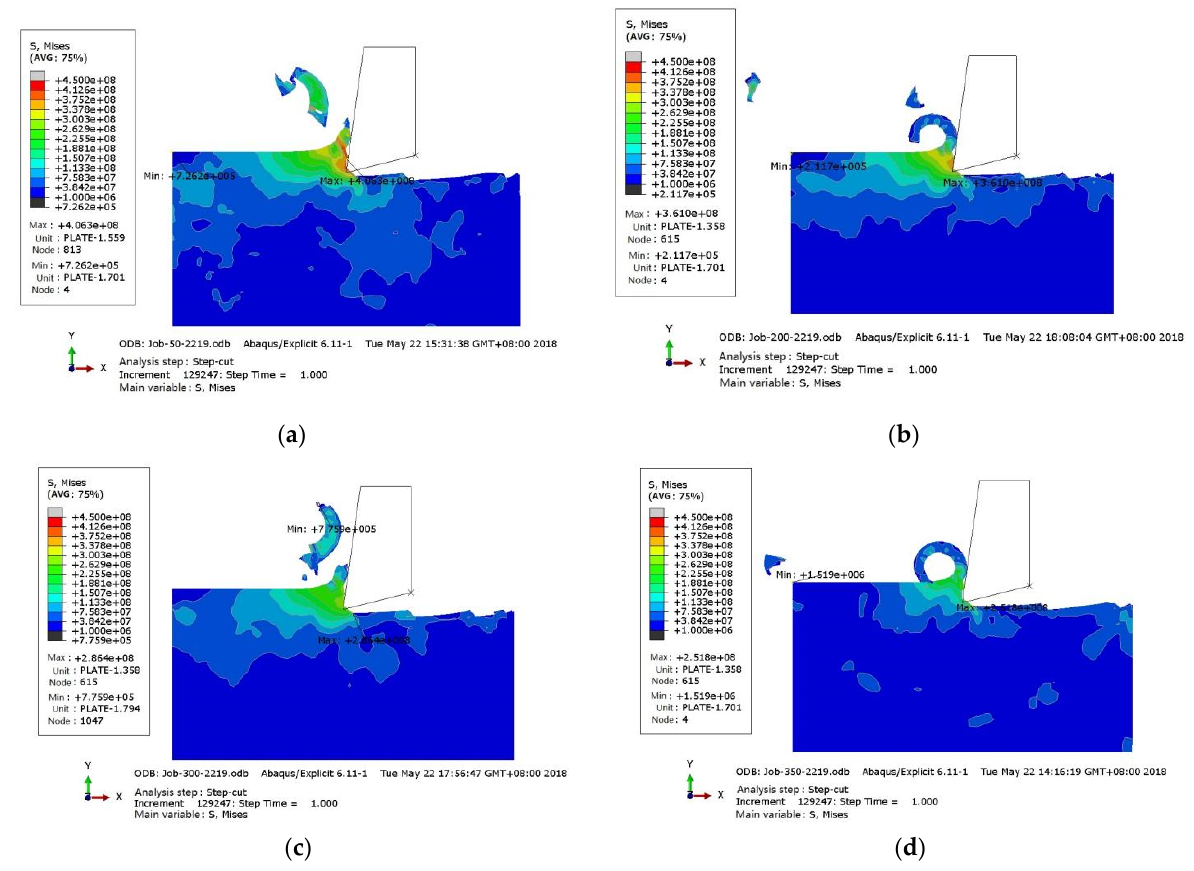
Figure 11. Cloud images for the simulation of Von Mises stress during thermally assisted cutting: ( a ) initial workpiece temperature of 50 ° C ; ( b ) initial workpiece temperature of 200 ° C ; ( c ) initial workpiece temperature of 300 ° C ; ( d ) initial workpiece temperature of 350 ° C . Table 8. Failure parameters for the Jonhson-Cook failure criterion of AA 2219 and AA 2A12. Matrix Material